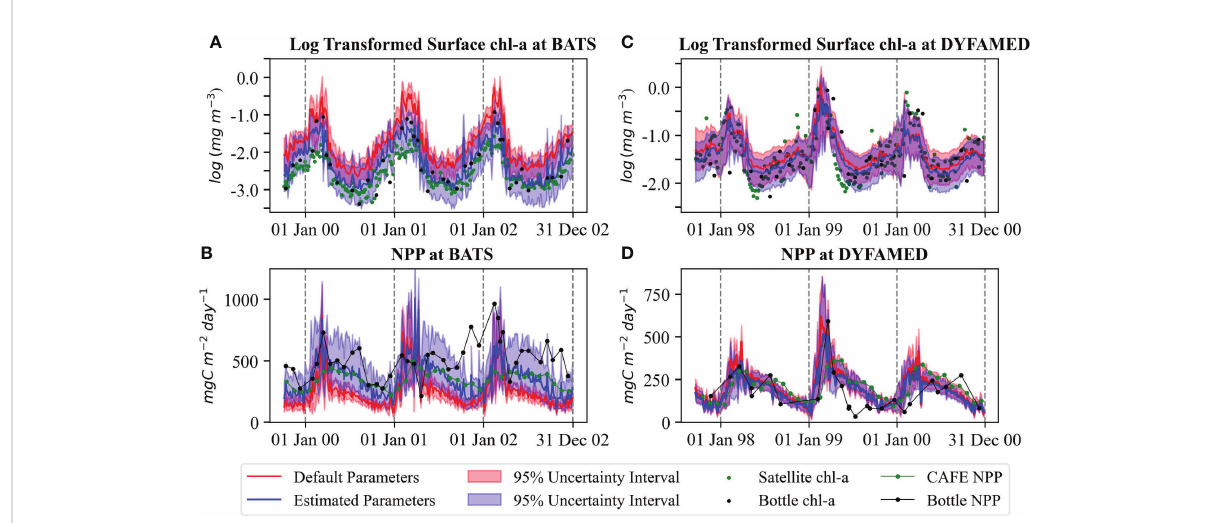
FIGURE 9 Comparison of log-transformed surface chl-a concentration of combined assimilation of satellite chl-a and in situ NPP simulations with default (EXP State_DP ) and estimated parameters (EXP State_EP ) at (A) BATS and (B) DYFAMED and of NPP simulations with default and estimated parameters at (C) BATS and (D) DYFAMED. The red line shows the ensemble mean with default parameters and the blue line is for estimated parameters. The green dots show satellite data, and the black dots are bottle